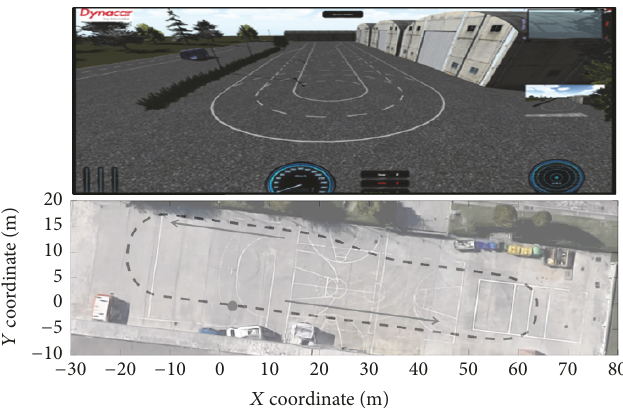
Figure 8: Derio 700 circuit: simulation and real one [30].